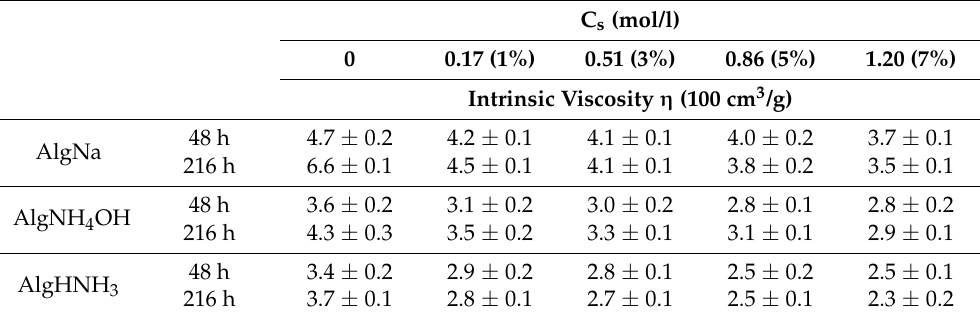
Table 3. The intrinsic viscosity values of diluted solutions of sodium alginate and ammonium alginate in the presence of